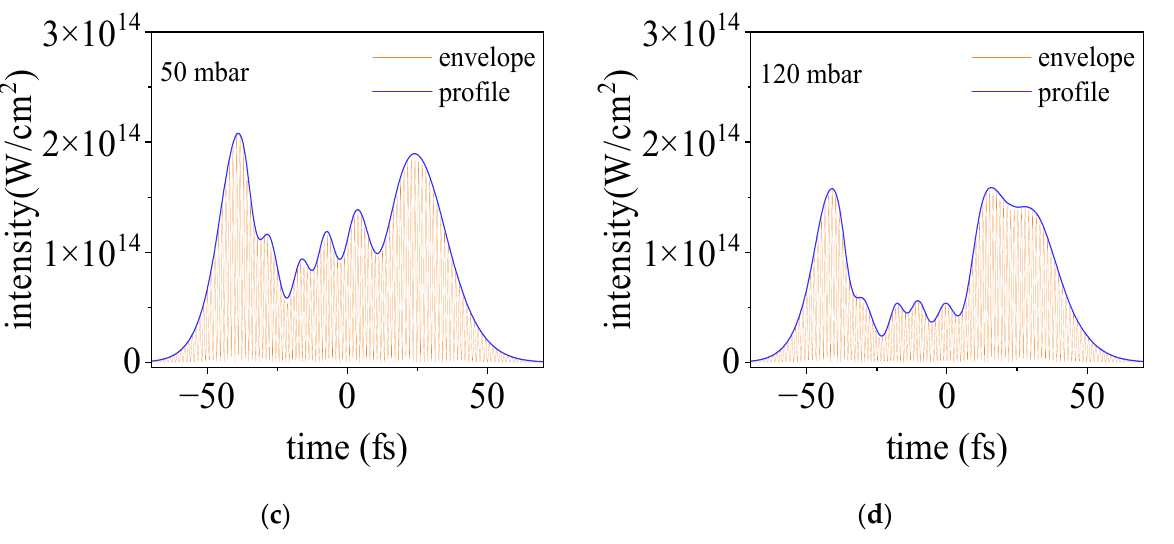
Figure 6. The temporal evolution of an intense femtosecond laser pulse propagating in argon. The gas pressures for ( a – d ) are 5, 20, 50, and 120 mbar, respectively.